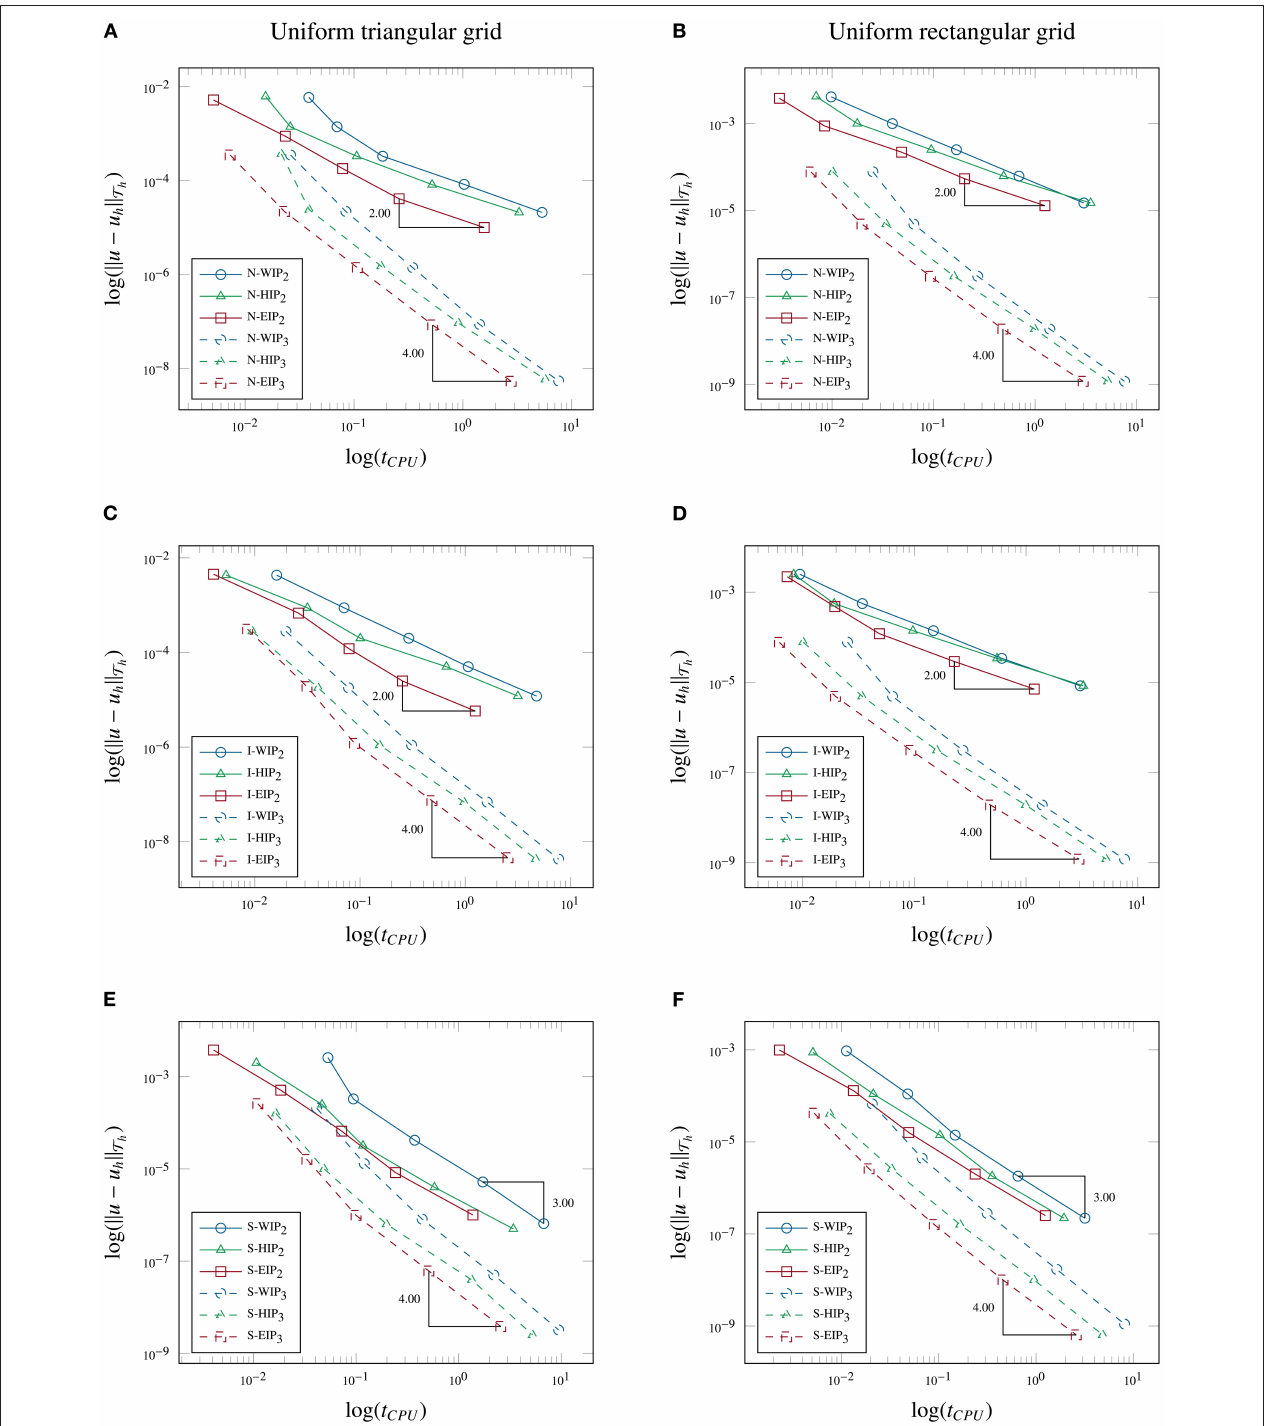
FIGURE 5 | Homogeneous case - History of convergence in the k · k T -norm (vs. h ) of the WIP, HIP, and EIP methods for the Non-Symmetric (A,B) , the Incomplete h (C,D) and the Symmetric variant (E,F) , respectively. The grid is triangular in the left (A,C,E) and rectangular in the right (B,D,F) .